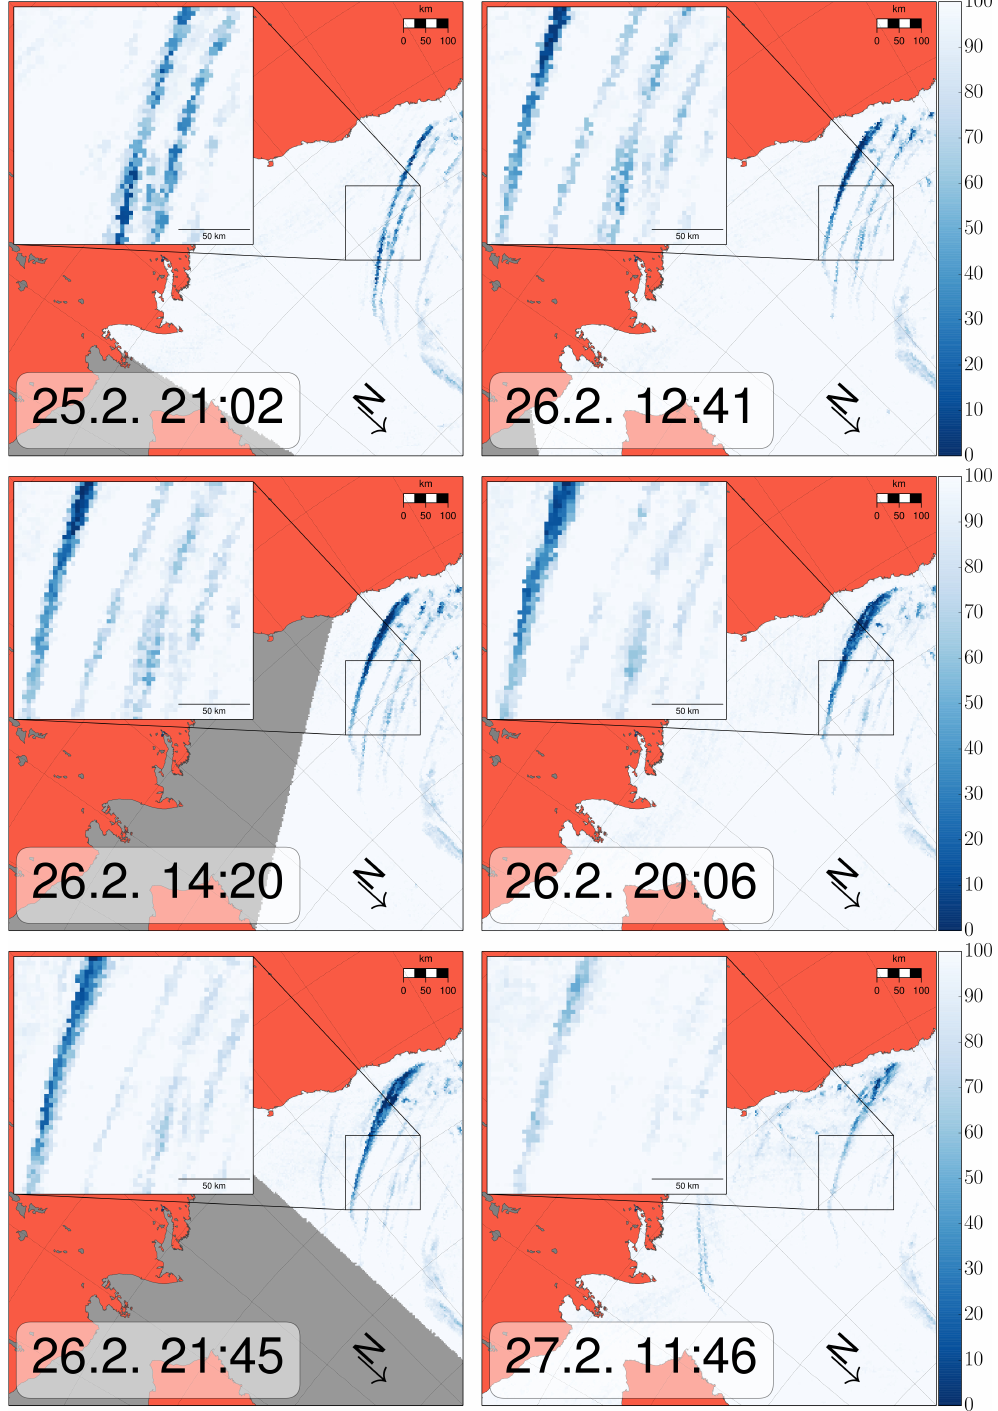
Figure 5. Evolution of the Feb-26-lead in ASI-3k from 25 February until 27 February 2013. We choose individual swaths, which cover the region of interest and depict the opening and refreeze of the Feb-26-lead. The date and start time of the individual swaths is displayed in the individual maps. The same projection and labeling as in Figures 1–3 apply. The gray areas depict missing